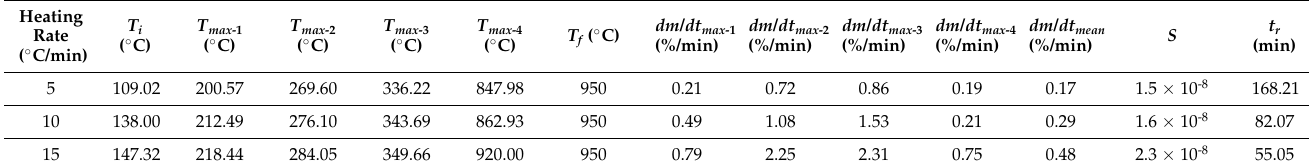
Table 3. The distinctive reduction parameter of the composite pellet at three different heating